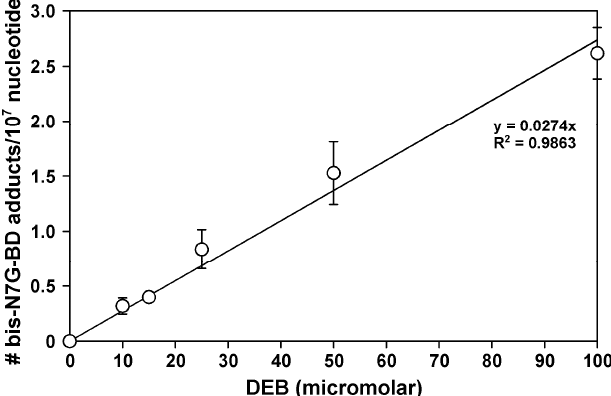
Figure 3. Concentration-dependent formation of bis -N7G-BD adducts in wild-type V79 cells treated with increasing amounts of DEB (10–100 µM). #, adduct numbers. Results represent average ± the standard error of the mean, n = 2.